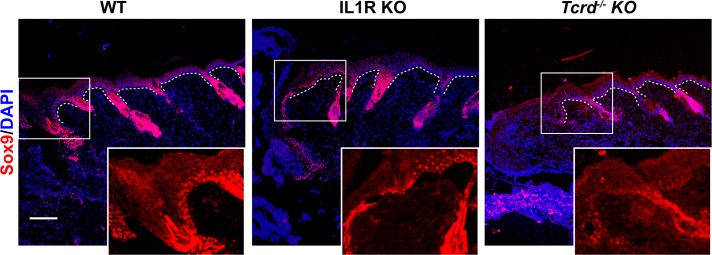
Sox9 expression in wounded skin.Skin sections from 8-week-old WT, IL1R KO, and γδT-cell KO mice were stained for Sox9 (red) to mark HFSCs and DAPI (blue) 3 days postwounding. White dotted lines denote the basement membrane separating the epidermis from the underlying dermis. Boxed regions are shown as a magnified image in the inset. Scale bar = 50 μm.